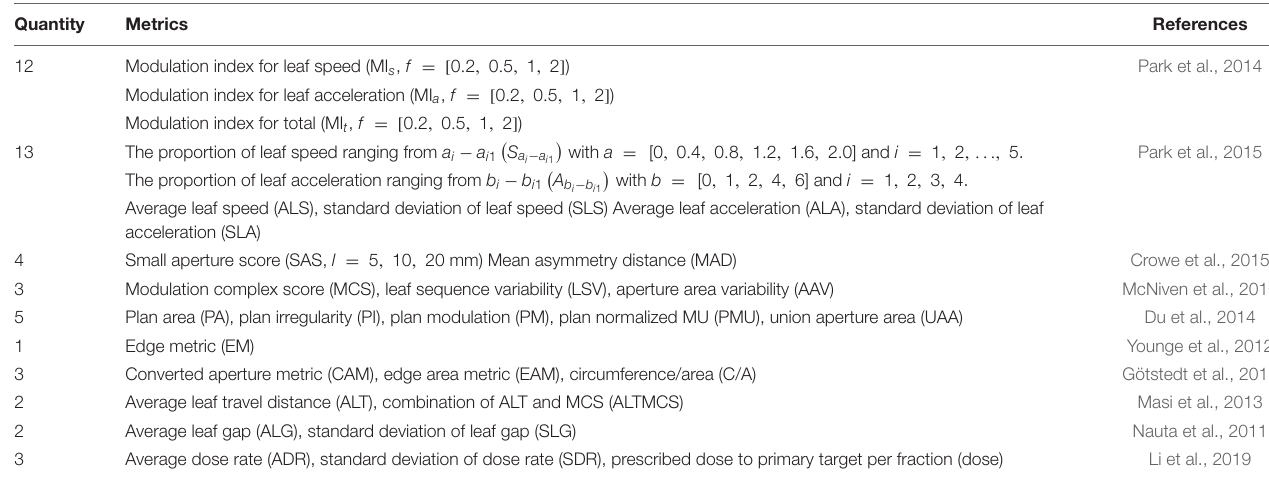
TABLE 1 | Conventional plan feature